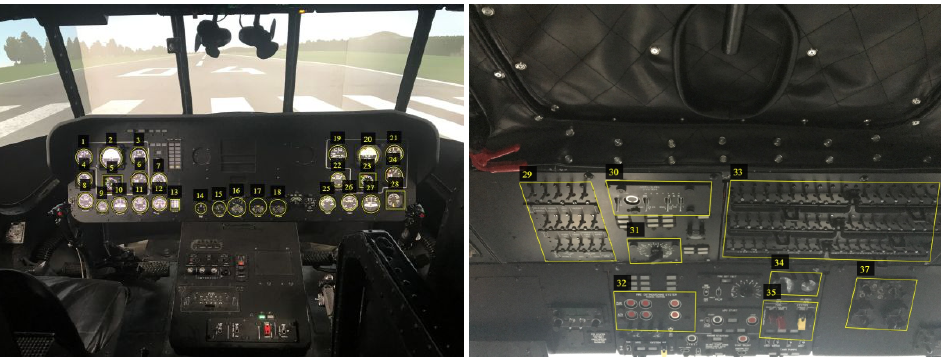
Figure 2. Interior of helicopter cockpit, in which the devices were photographed to prepare the WrightBroS image database. On the left, one can see the front panel. On the right, one can see the top panel.